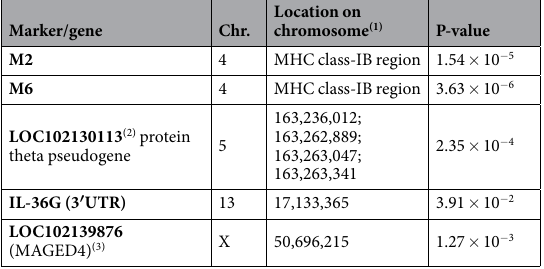
Table 4. Multiple linear regression. (1) locations on chromosomes ( Macaca fascicularis RefSeq assembly GCF_000364345.1). (2) In the LOC102130113 we identified four candidate SNPs for which the 42 animal